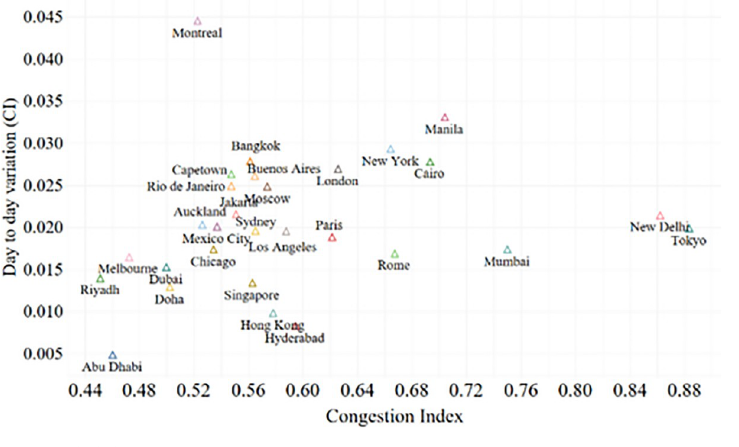
Fig 5. Reliability.